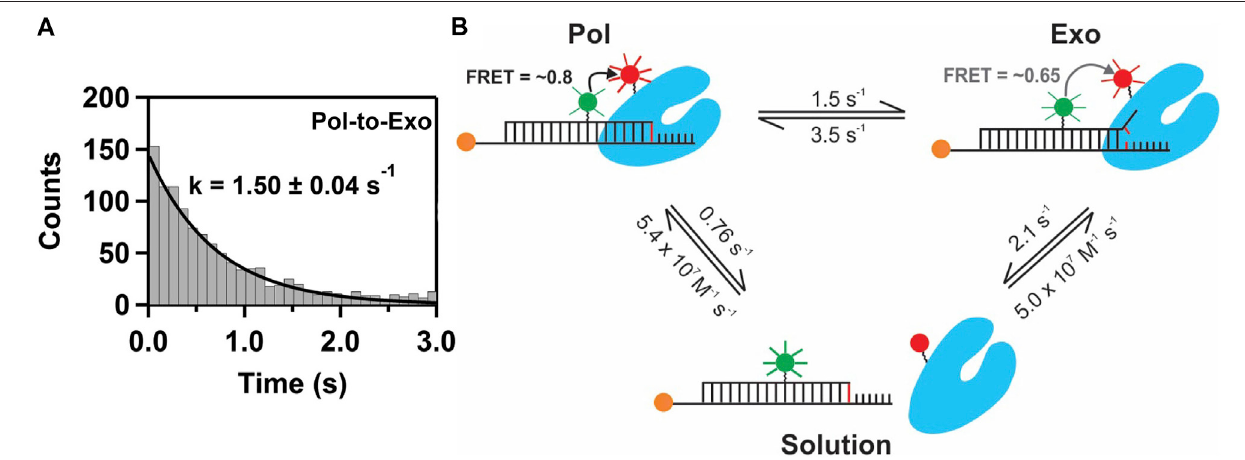
FIGURE6| PathwaysandrateconstantsforswitchingofDNAbetween pol and exo sitesinKF. (A) Dwelltimehistogramfordirecttransitionsfromthe pol sitetothe exo site. The smoothline isthe best fi t toa single exponential function,withthe rateconstantindicated. (B) Summaryofthe two observedtransferpathways.The intramolecular transfer pathway between bound complexes is shown at the top, together with the measured rate constants obtained from dwell time analysis ofsmFRET trajectories. The intermolecular pathway, involving dissociation from one site and rebinding from solution to the other site, is shown below, together with the respective rate constants.